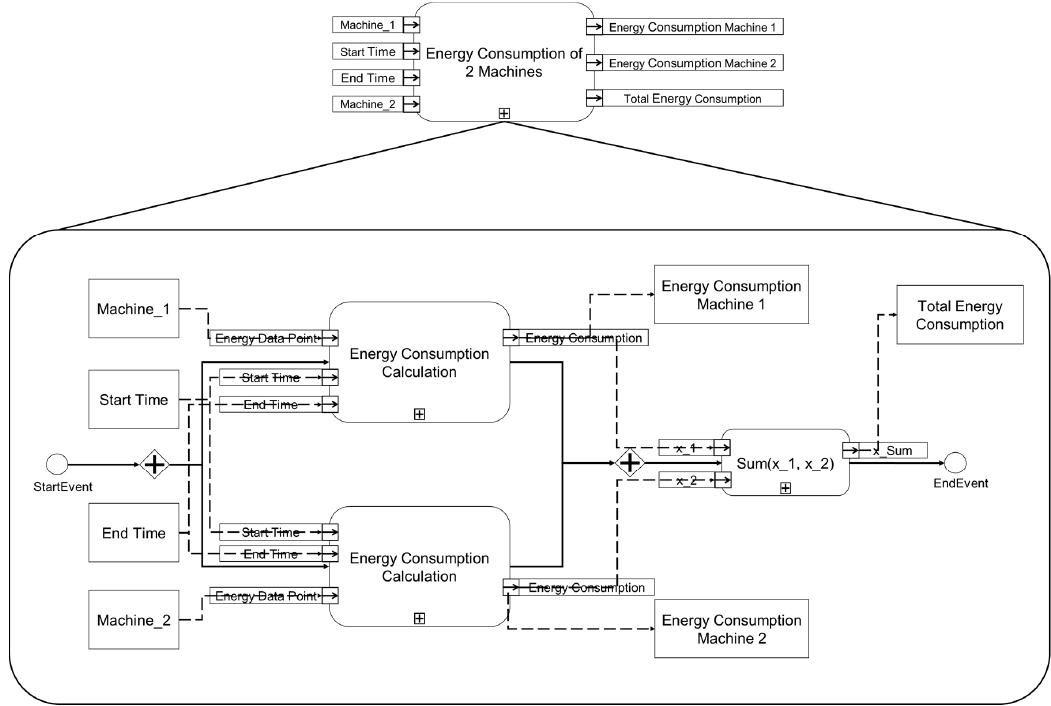
Figure 12. MES function model to fulfill the demands on the MES for energy management.